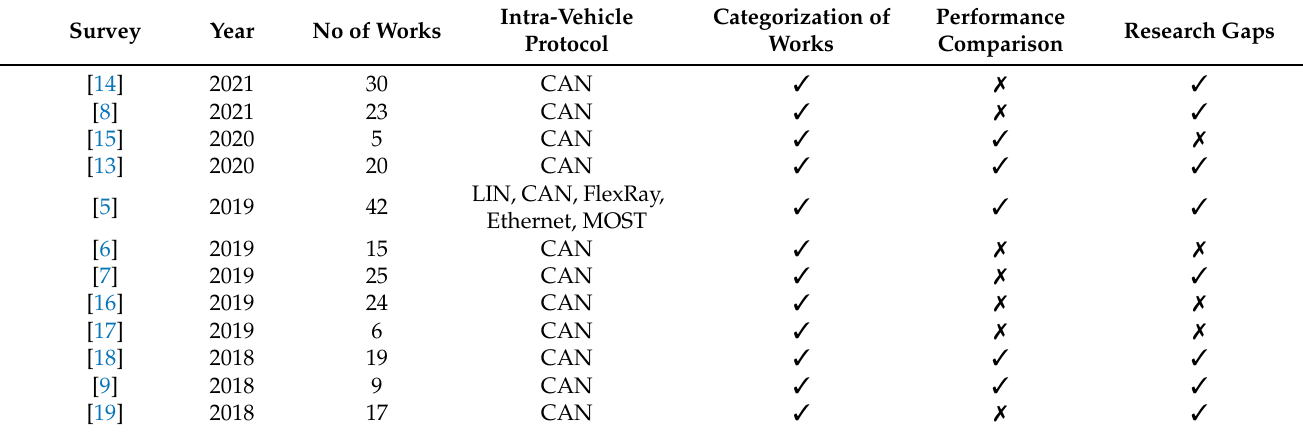
Table 1. Summary of previous survey works on the field of IVN IDS sorted by year in descending order. (cid:51) : provided, (cid:55) : not provided.